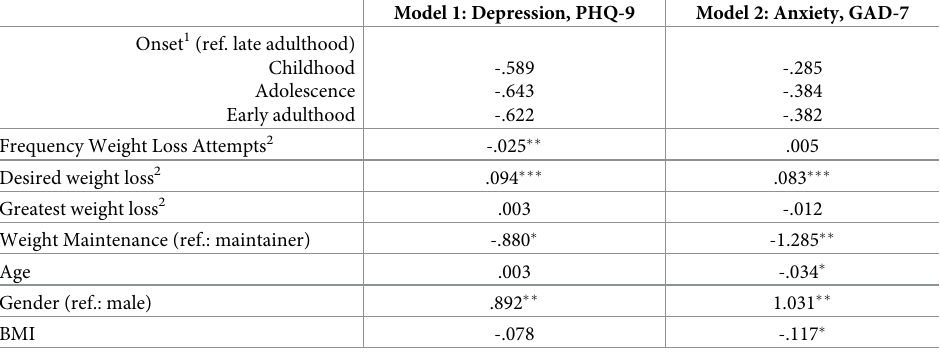
Table 3. Multiple regression analysis with depression (Model 1) and anxiety (Model 2) as dependent